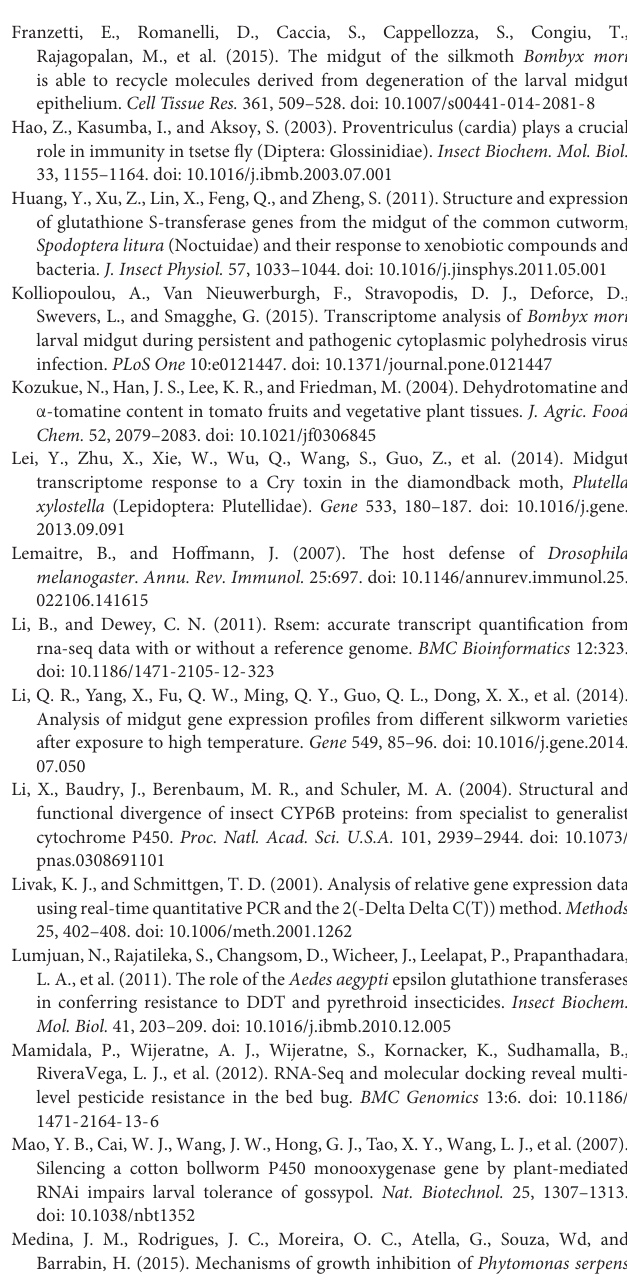
FIGURE S1 | Chemical structures of tomatine. FIGURE S2 | GO classification diagram. FIGURE S3 | KOG classification diagram. TABLE S1 | Specific primers used in qRT-PCR. TABLE S2 | Fold change of up-regulated genes in RNA-seq and the qRT-PCR. TABLE S3 | Specific primers used in Synthetic dsRNA. TABLE S4 | Splicing length and frequency distribution of transcripts and unigenes. TABLE S5 | Success rate of gene